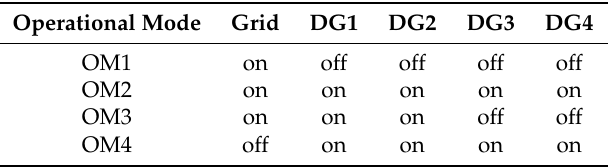
Table 1. Microgrid operational modes.